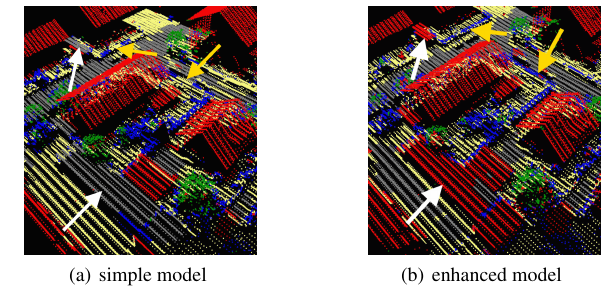
Figure 3: Comparison of the results obtained by a simple and an enhanced CRF model. For instance, garages (white arrows) and hedges (yellow arrows) are better detected with the complex